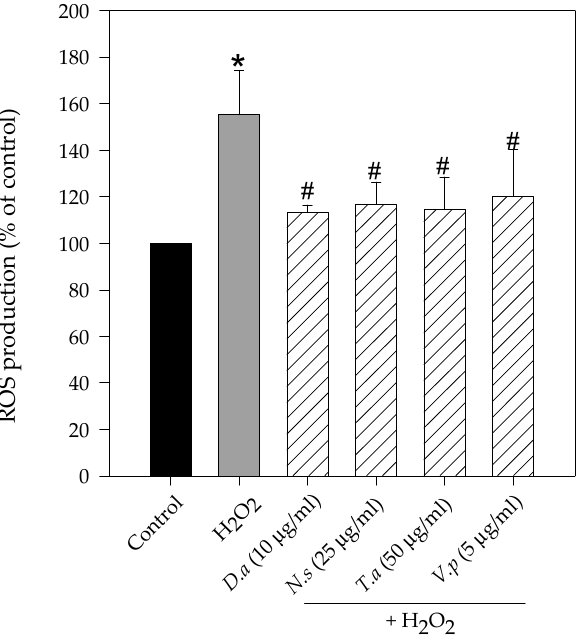
Figure 3. Effect of methanol lichen extracts of cetrarioid clade on intracellular ROS production. SH-SY5Y cells were pretreated with D. arctica ( D.a ), N. stracheyi ( N.s. ), T. americana ( T.a ) and V. pinastri ( V.p ) for 24 h before H 2 O 2 (250 µM, 1 h). The levels of intracellular ROS production were measured using dichlorodihydrofluorescein diacetate (DCFH-DA) method. Results are expressed as mean ± SD (triplicate experiments). * p < 0.01 versus control; # p < 0.01 versus H 2 O 2. 2.3. Lichen Extracts from Cetrarioid Clade Improved Oxidative Stress Markers and Antioxidant Enzyme Activity